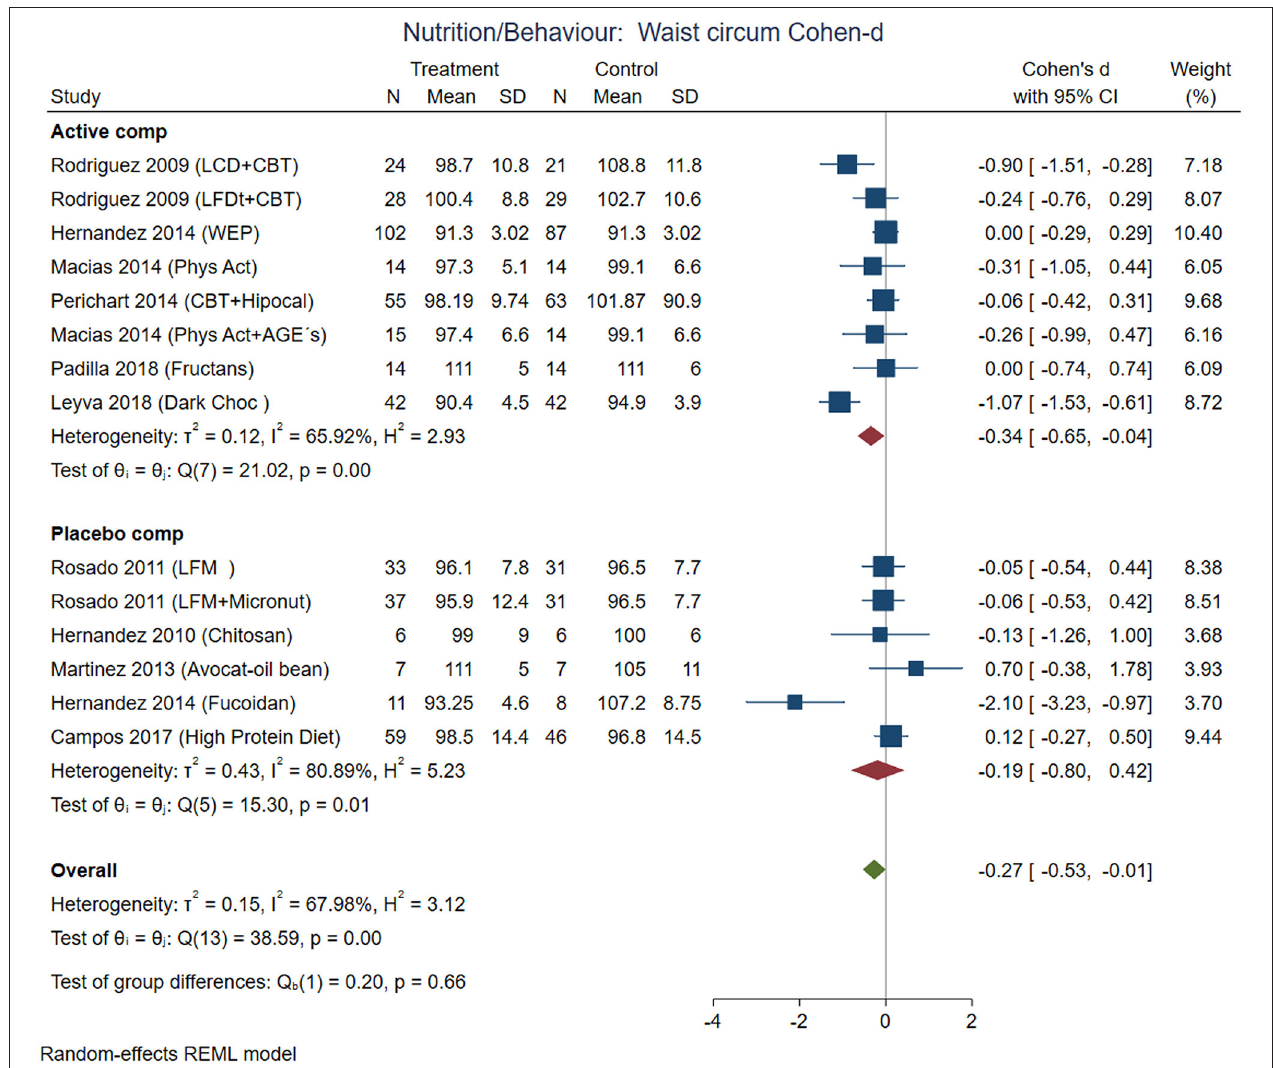
FIGURE 4 | Pooled analysis of Cohen’s d-weighted effect size on waist circumference with nutritional and behavioral interventions. The analysis was stratified by placebo or active comparator. LFDT, Low fat diet; LCD, Low carbohydrate diet; CBT, Cognitive-behavioral therapy; Phys Act, Physical activity; Dark Choc, Dark chocolate; AGE, Advanced glycation end-product; Hipocal, Hypocaloric diet; LFM, Low fat milk; Micronut, Micronutrients; PMR, Partial meal replacement; REML, Restricted maximum